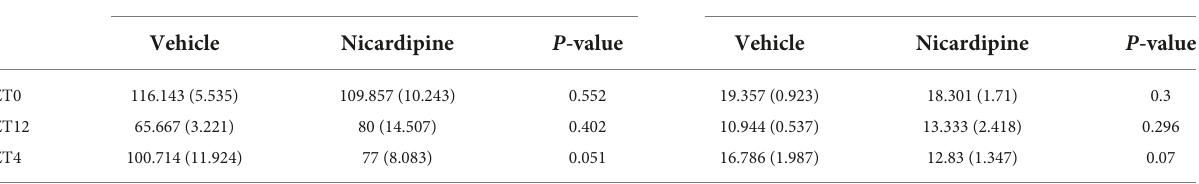
TABLE 2 Mean number of NREM episodes and mean NREM episode